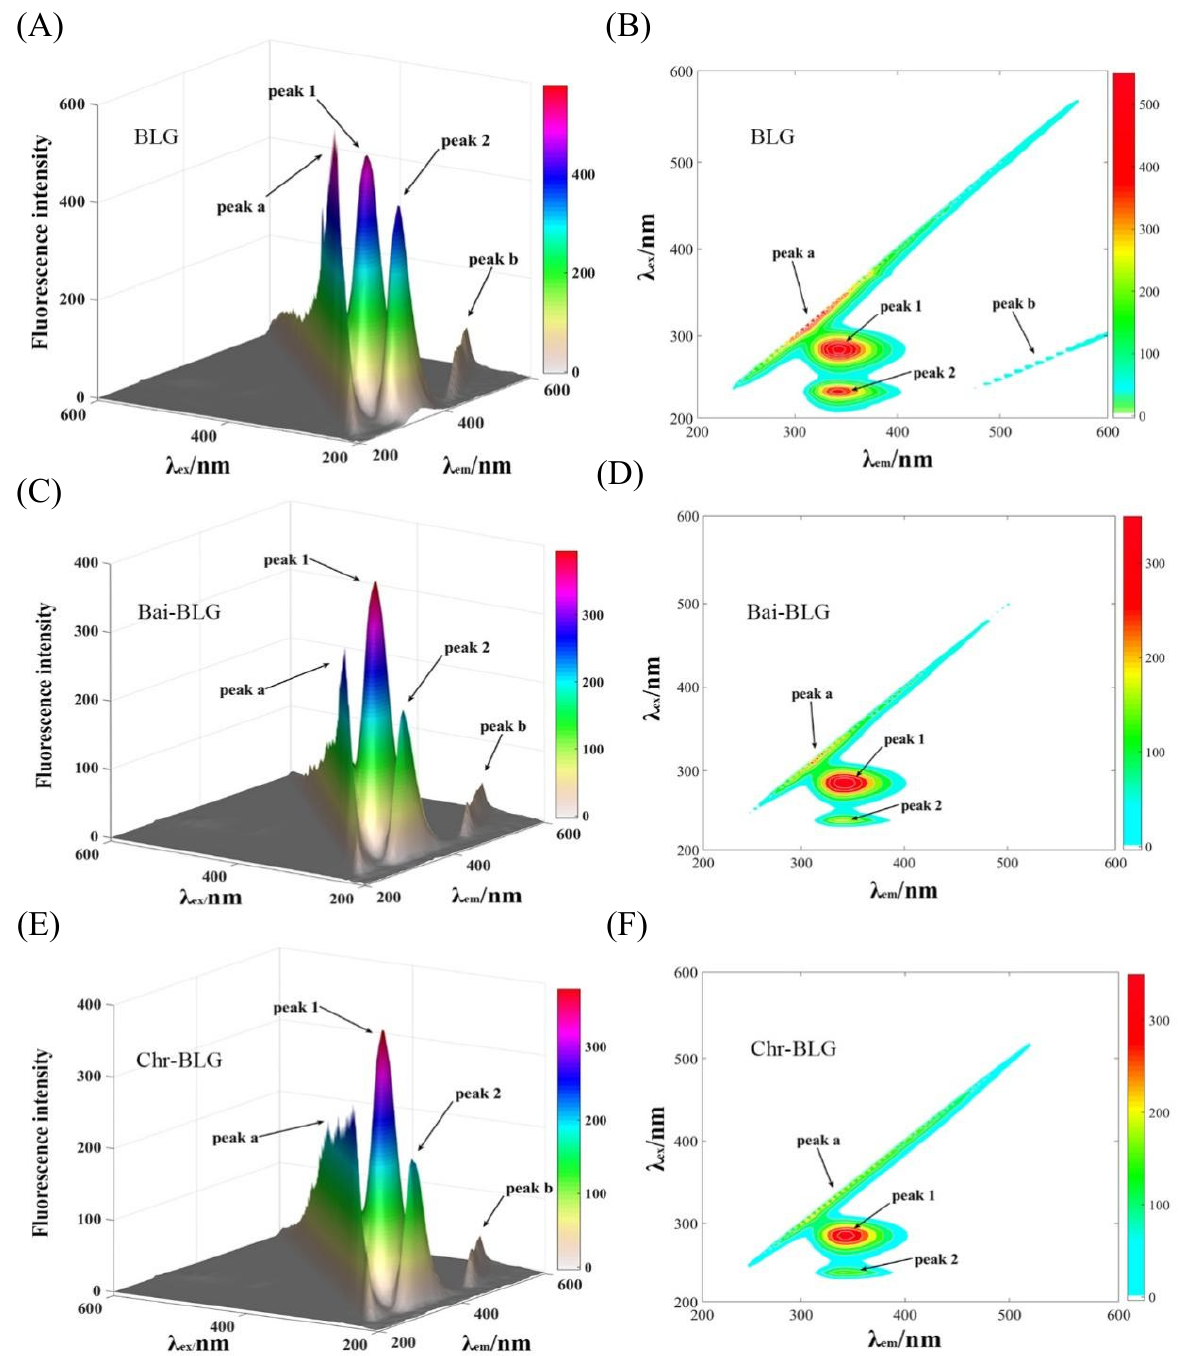
Figure 2. 3D fluorescence spectra of free BLG ( A ), Bai–BLG ( B ), and Chr–BLG ( C ) systems. Contour maps of free BLG ( D ), Bai–BLG ( E ), and Chr–BLG ( F ) systems. c (BLG) = 20.0 µ M, c (Bai/Chr) = 20.0 µ